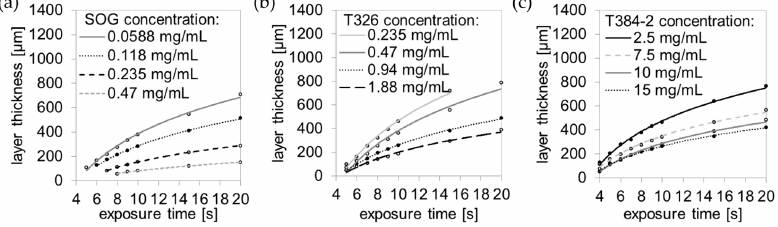
Figure 2. Layer thickness of printing formulations as a function of the exposure time. The Layer thickness of printing formulations as a function of the exposure time. polymerization curve flattens with increasing absorber concentration (final absorber concentration in MD700). Layer thickness as a function of the exposure time for different SOG ( a ), T326 ( b ), and T384-2 ( c ) concentrations.